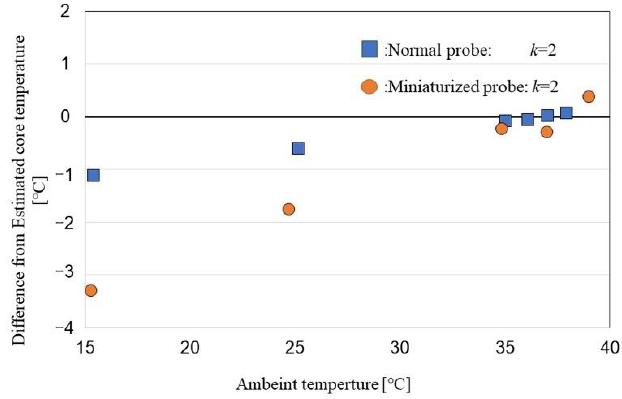
Figure 4. DBT error according to ambient temperature.